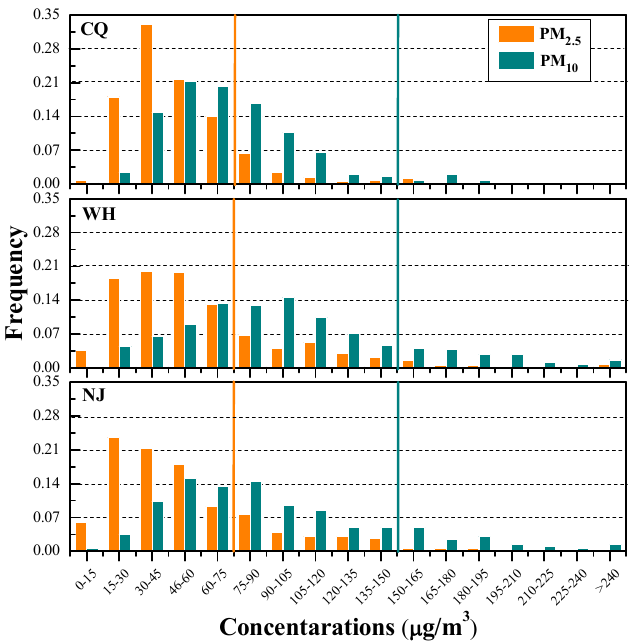
Figure 2. Frequency distributions of daily PM 2.5 and PM 10 in Chongqing (CQ), Wuhan (WH), and Nanjing (NJ). Note: the CAAQS-II standards of daily average are plotted as straight lines.